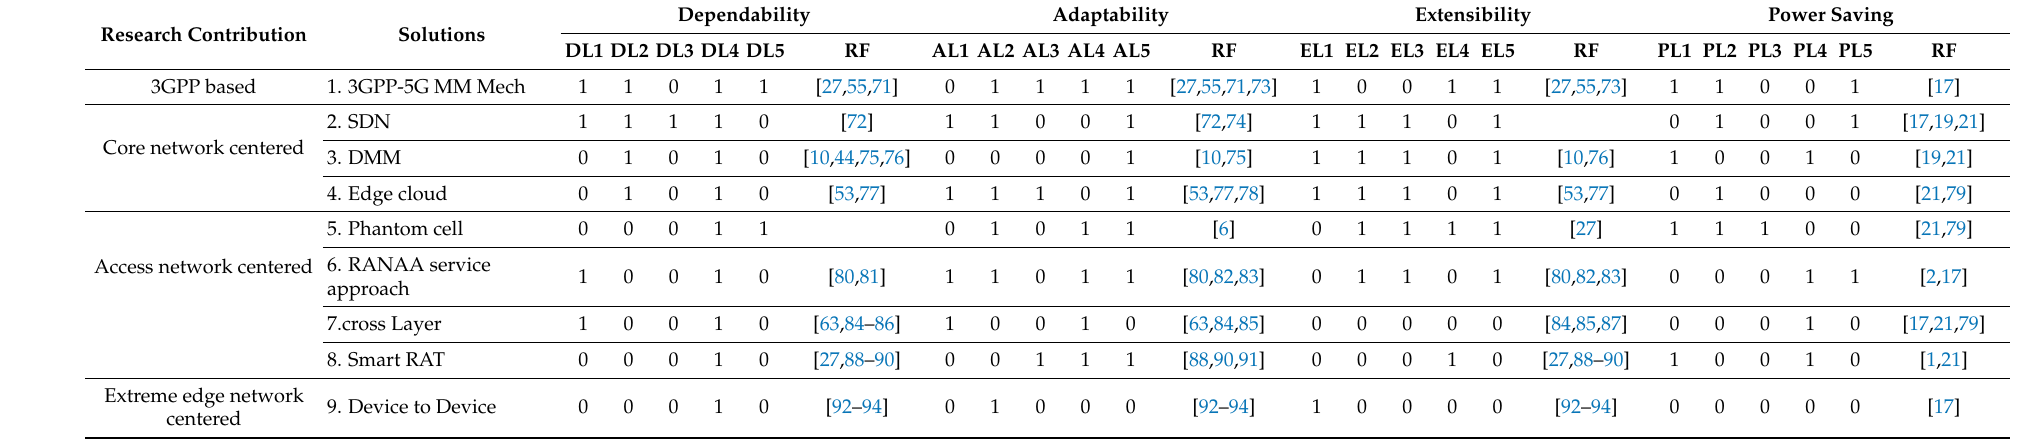
Table 4. Compliance with dependability, adaptability, extensibility, and power saving for 5G MM